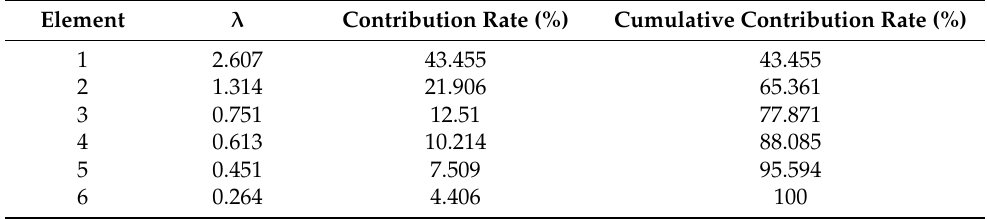
Table 11. Variance expression of major parameters from